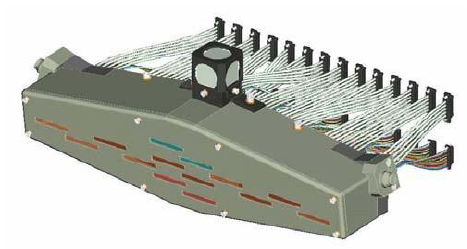
Figure 1. Mars HiRISE camera focal plane diagram (picture source: NASA official website)